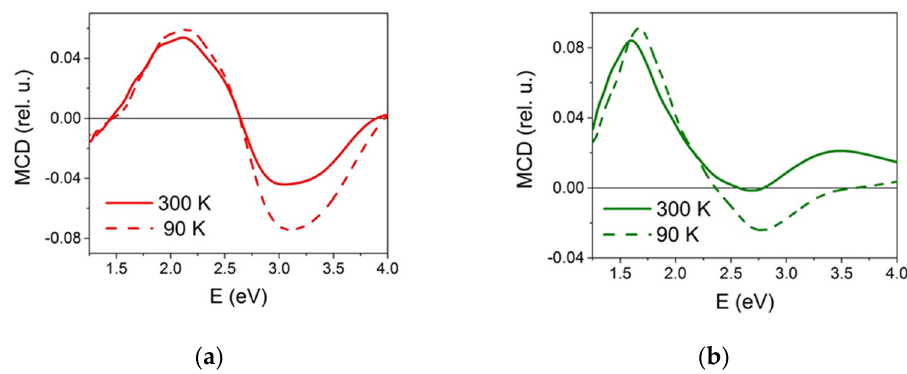
Figure 10. MCD spectra of Fe 3 O 4 @C ( a ) and Fe 3 O 4 @C@C ( b ) samples at 90 and 300 K.